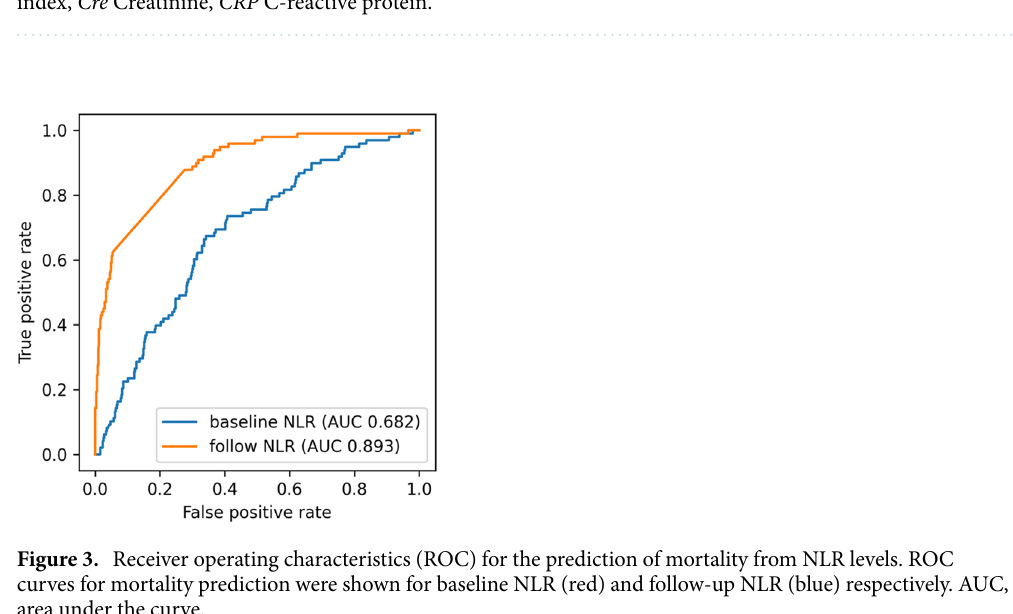
Table 3. Factors associated with 30-day mortality in hospitalized patients with COVID-19. BMI body mass index, Cre Creatinine, CRP C-reactive protein.